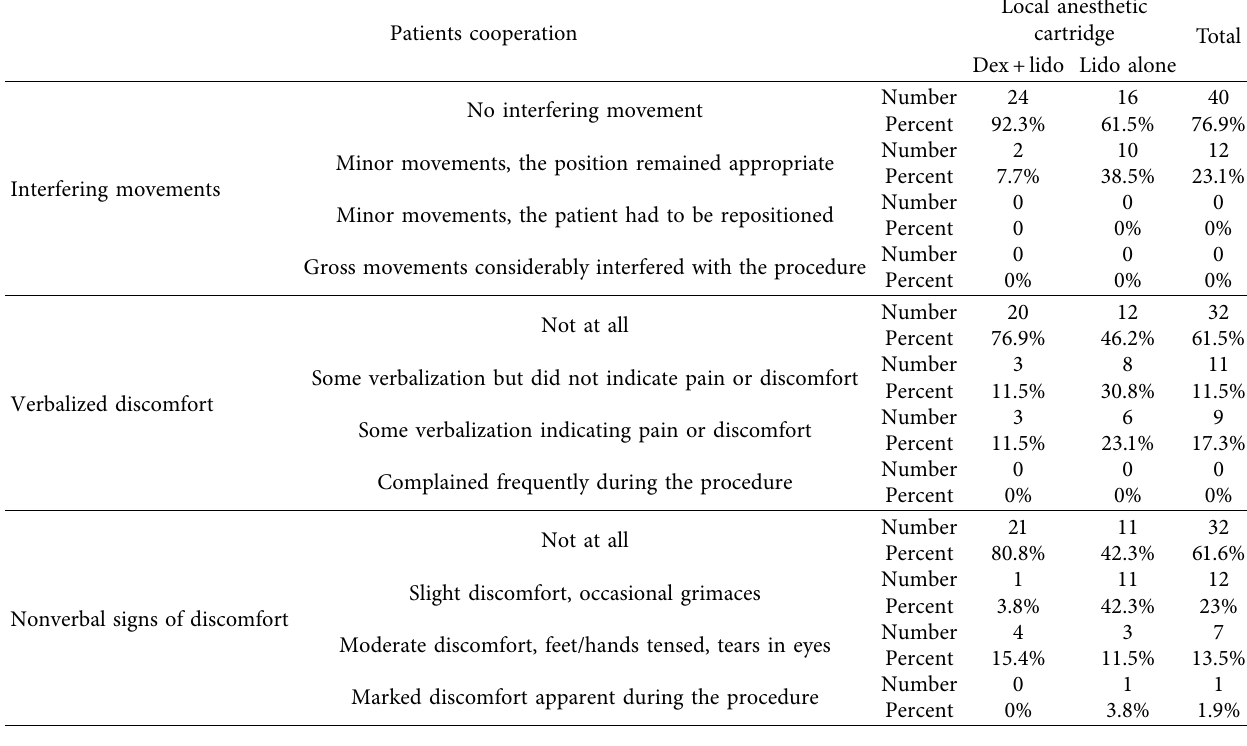
Table 2: Patients cooperation values were reported in three parts including interfering movement, verbalized discomfort, and nonverbal signs of discomfort.